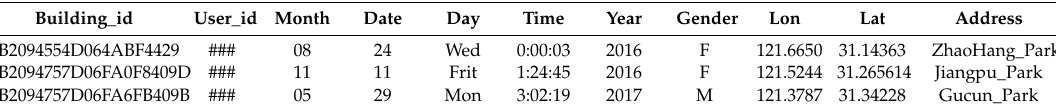
Table 2. Example of Weibo check-in data.